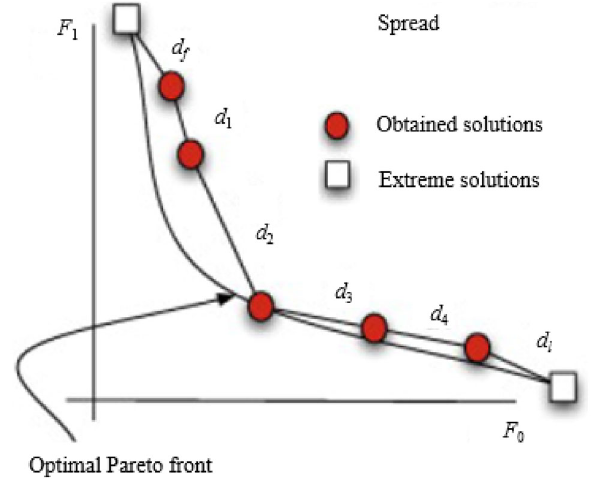
Fig. 4 Distances from extreme